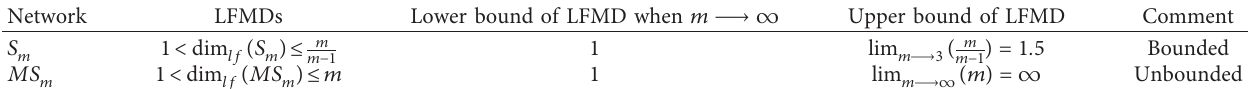
Table 3: Bounded and unboundedness of LFMDs.